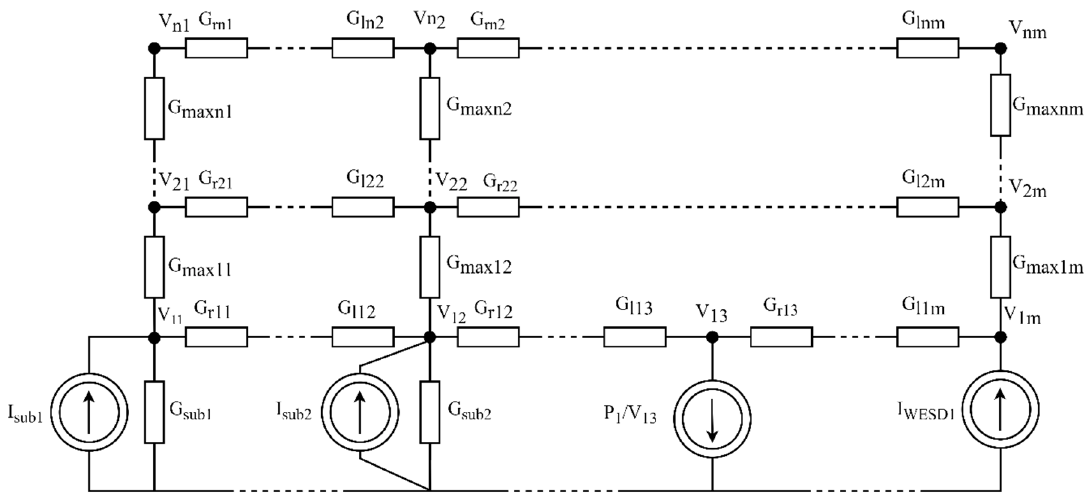
Figure 1. Multi-track section with the nodes and conductance designation.